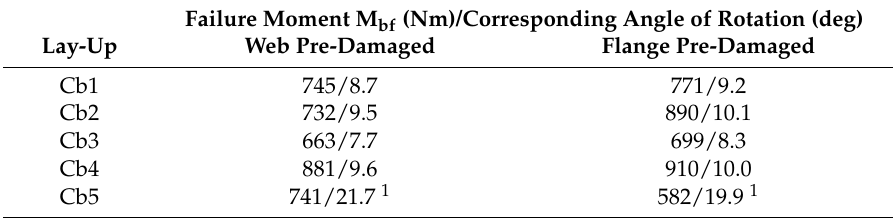
Table 5. Failure moments with corresponding angle of